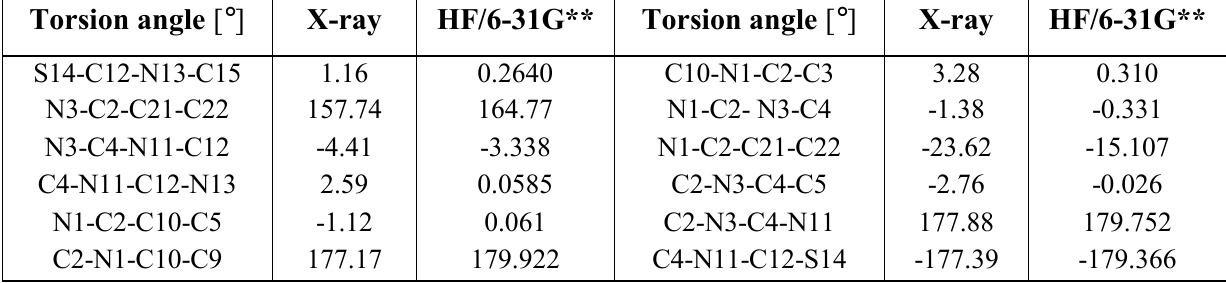
Table 3. The most important torsion angles in 7f